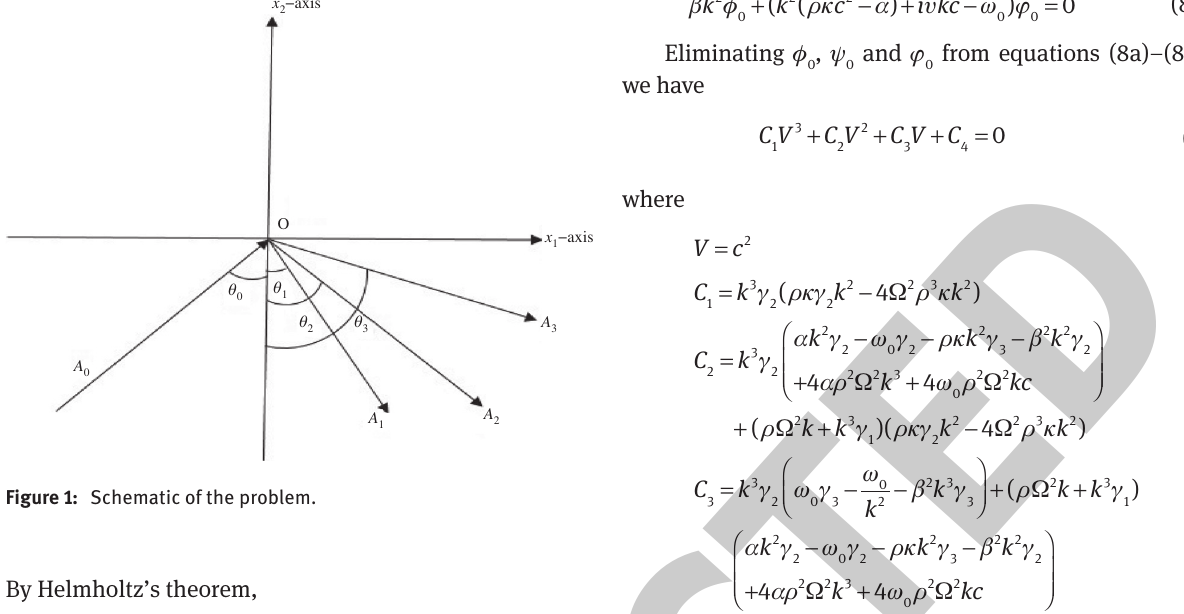
Figure 1: Schematic of the